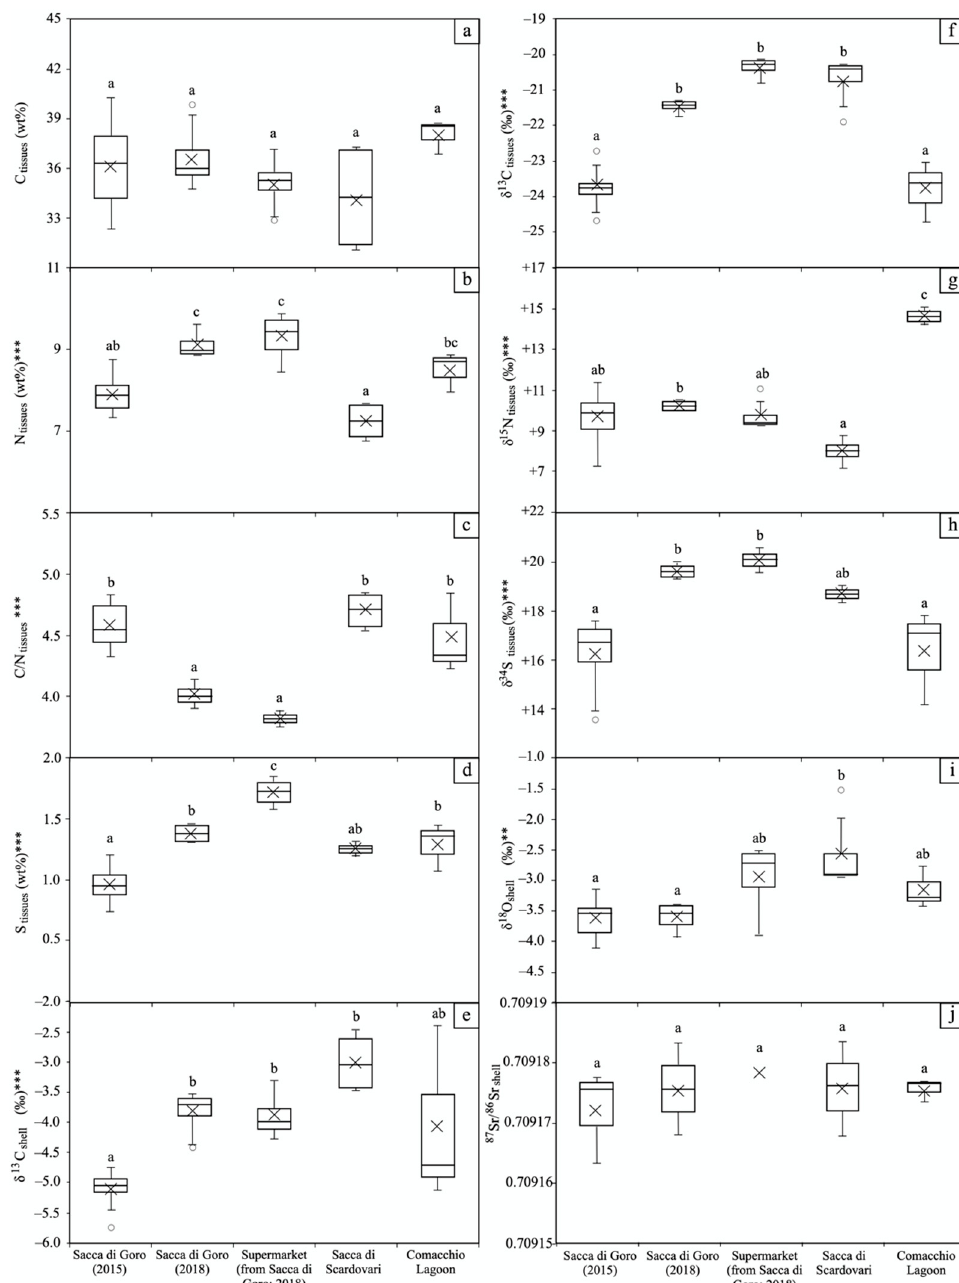
Figure 2. Box plot of elemental and isotopic compositions of carbon (C), nitrogen (N), sulfur (S), oxygen (O), and strontium isotope composition ( 87 Sr/ 86 Sr) in the tissues (a-d; f-h) and shells (e; i-j) of manila clam samples collected on-site from northern Adriatic lagoons and bought at the local su- permarket. In each box plot, the black line and the black cross represent the median and the mean, respectively. Above the box plots, the letters represent the results of the Tukey’s HSD post hoc test: different letters denote significant differences among groups. The one-way ANOVA results are also reported (** p < 0.001; *** p < 0.0001); where the asterisks are missing the groups are not statistically different.